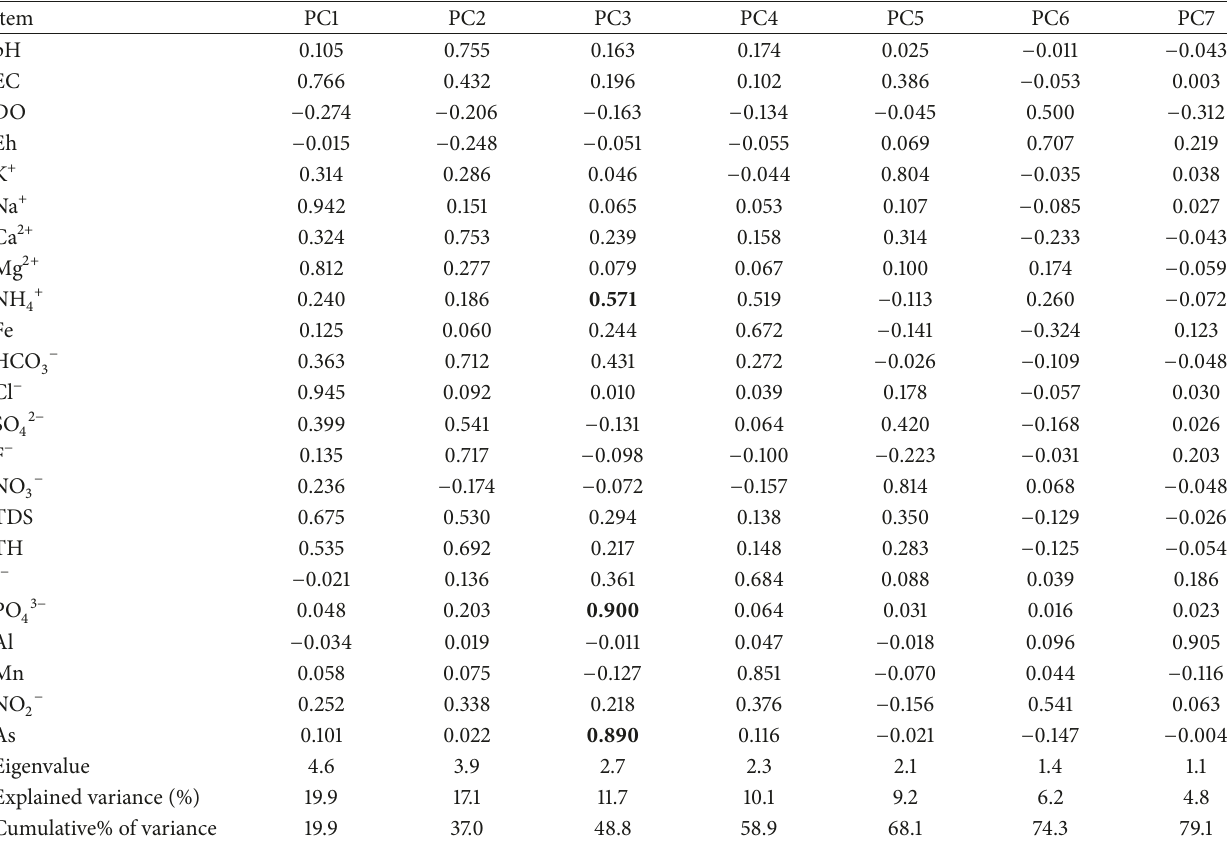
Table 2: Principal component (PC) loadings for groundwater samples in granular